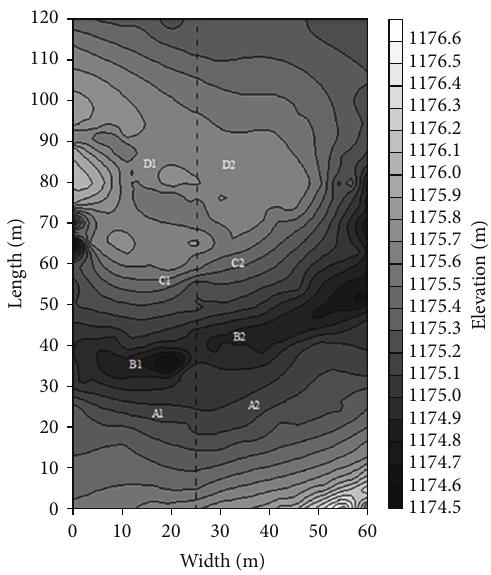
Figure 2: Topographical map of the study